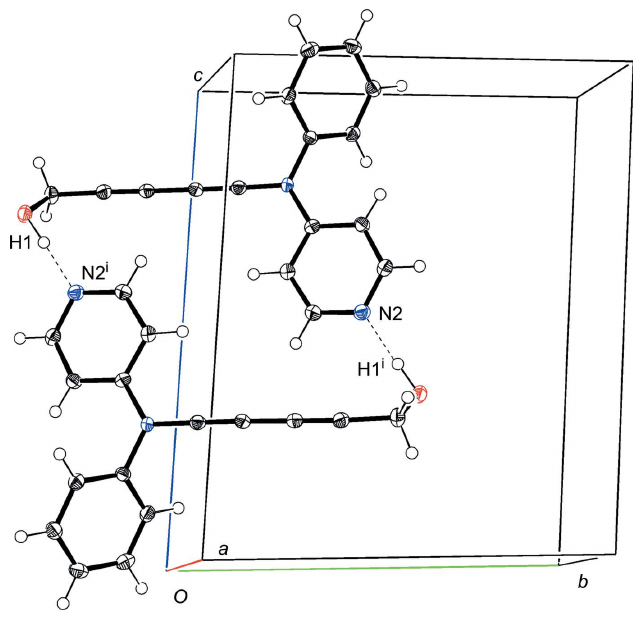
Figure 2 A view of the hydrogen-bonded dimer of the title compound [symmetry code: (i) -x + 1, -y + 1, -z ].